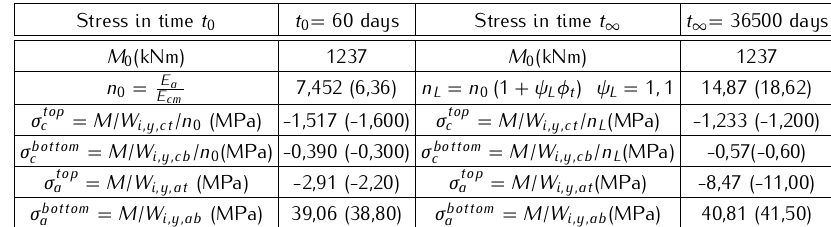
Table 2. Level of stresses of composite beams according ACI209R-92 model, in comparison with CEB